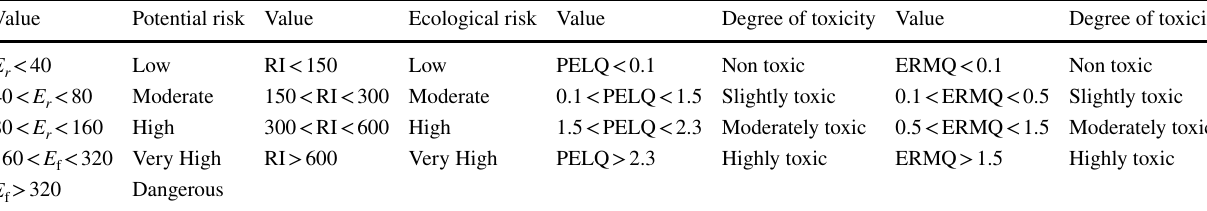
Table 7 Classification of E